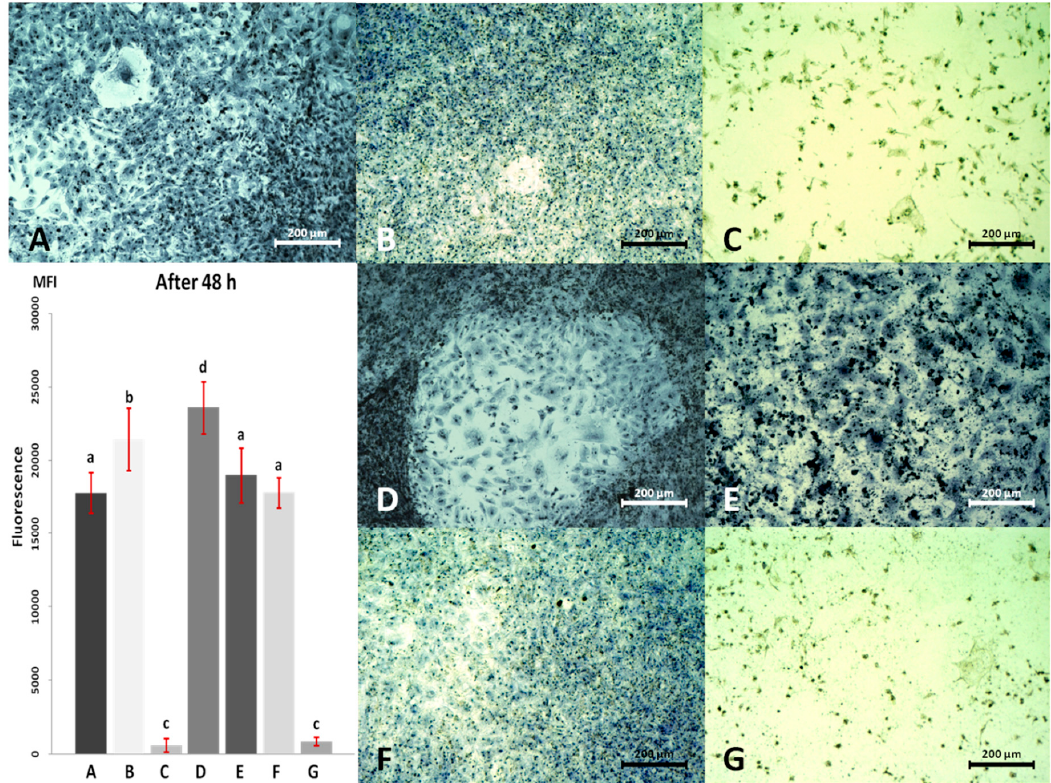
Figure 5. Morphology of cardiac progenitor cells cultured with the addition of 10 µ g / mL AgNP after 24 h. Magnifications: ( A ) 100 × ; ( B ) 200 × ; ( C ) 400 × . Results of the viability test and cells morphology after 48 h are presented in Figure 6.